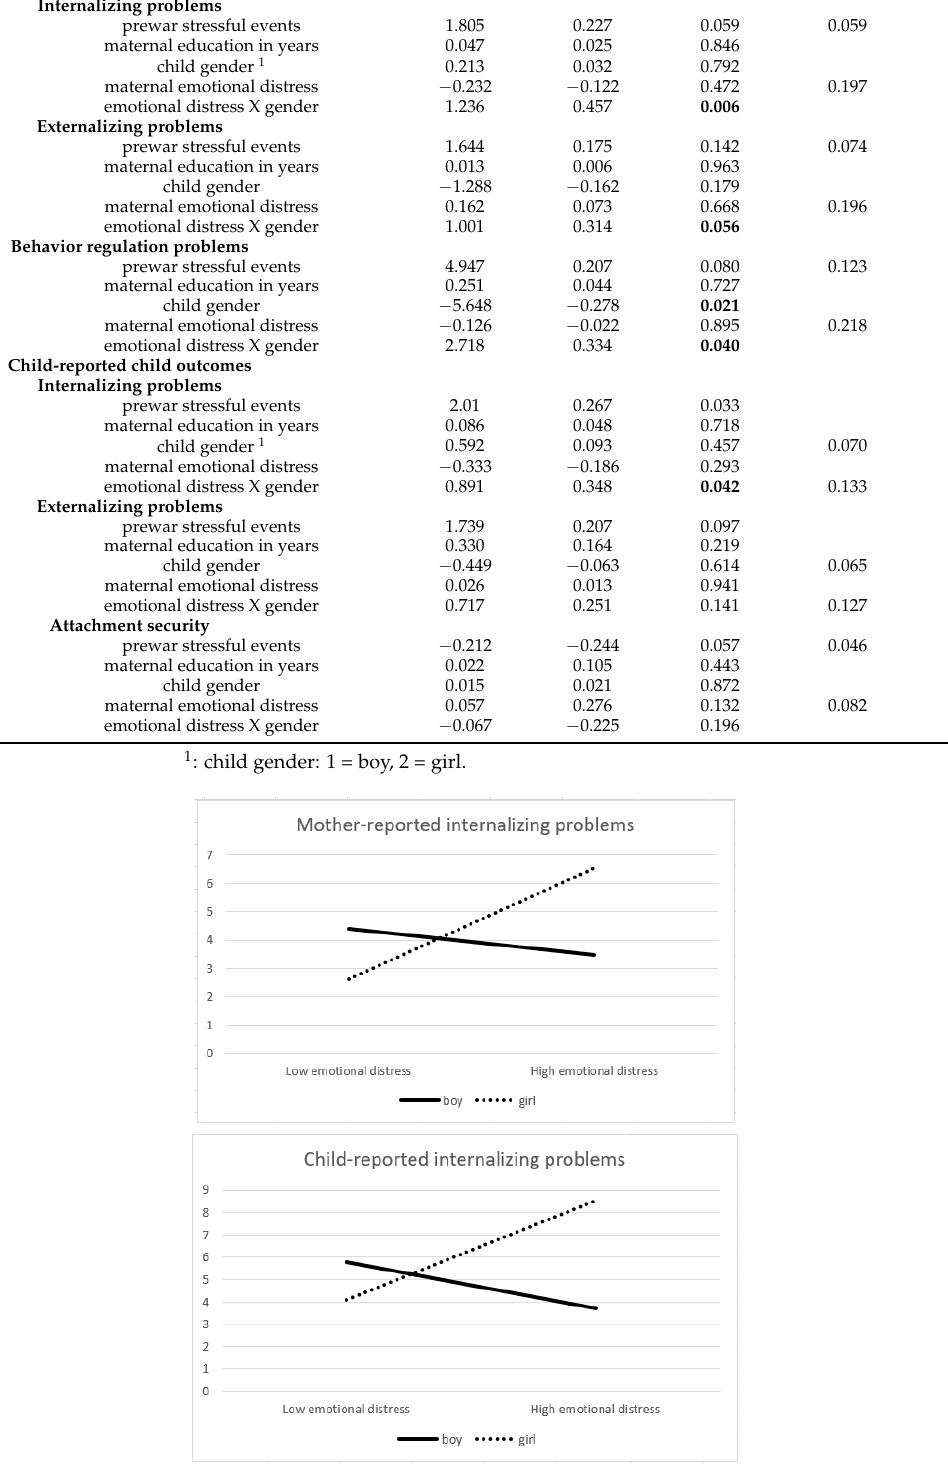
Table 4. Results of the multiple hierarchical regression analyses predicting child outcomes as reported by the mother. B β p R 2 Model F change R 2